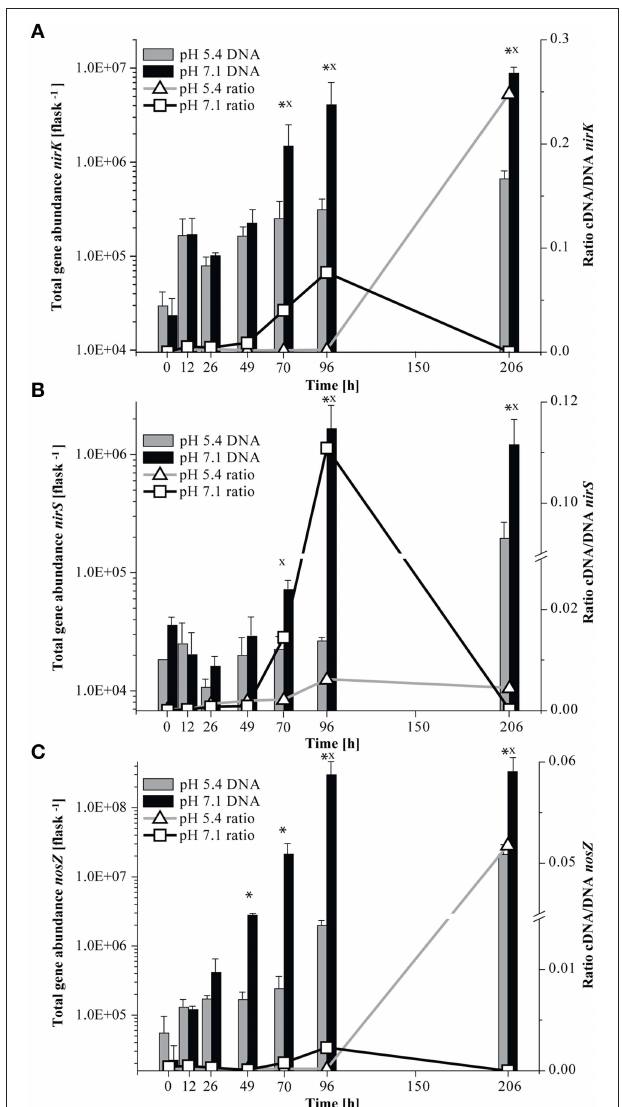
FIGURE 3 | Abundance of functional marker genes for denitrification ( nirK , nirS , and nosZ ) quantified by qPCR and ratio of cDNA/DNA copy numbers. Left axis, total gene abundance and right axis, ratio of cDNA/DNA copy numbers. Bars indicate the total gene copy numbers and the line the cDNA/DNA ratio. An asterisk indicates significant differences in gene abundance, x indicates significant differences in the ratio of cDNA/DNA copy numbers between incubation at pH 5.4 and pH 7.1 at a given time point (ANOVA: P < 0.05 ). (A) nirK ; (B) nirS ; (C) nosZ (Mean ± SD, n = 3